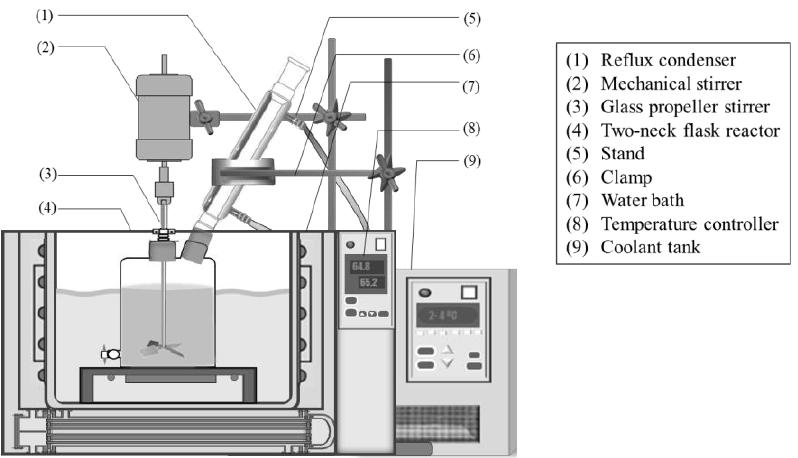
Figure 6. Experimental set up for transesterification of biodiesel production from refined palm oil in a batch reactor.